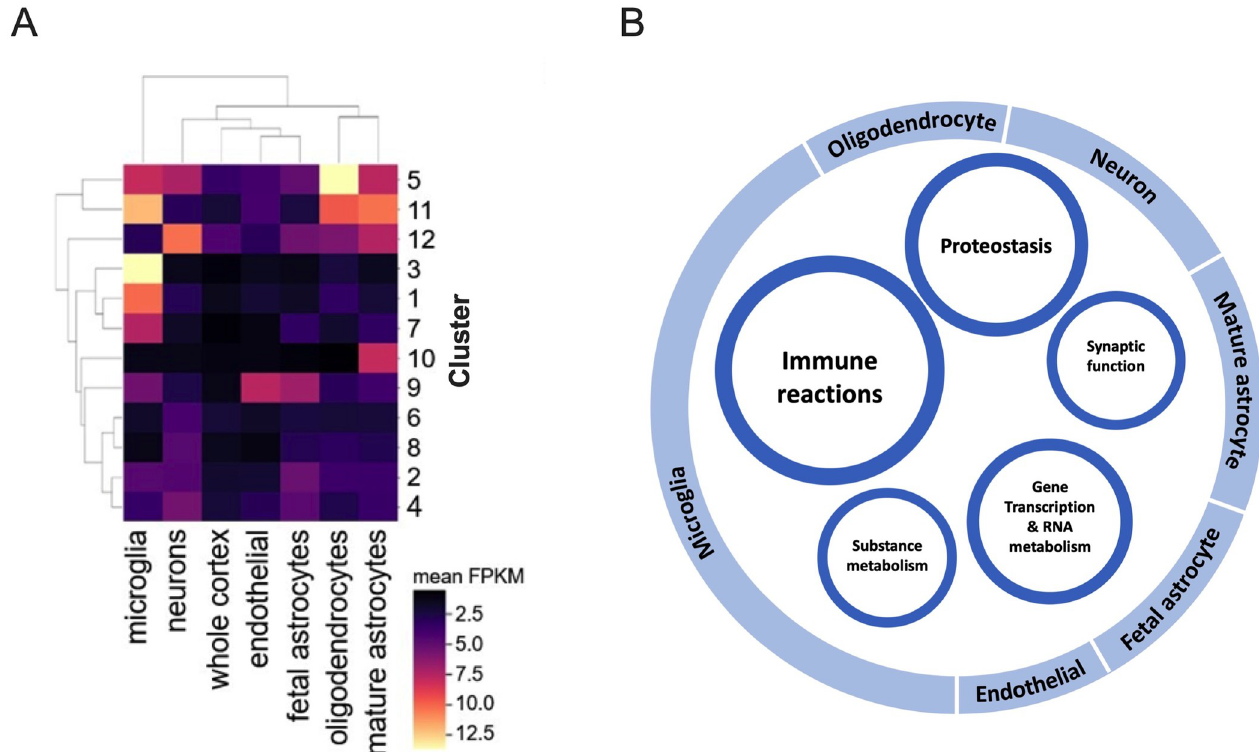
Fig 5. Cell-specific gene expression across clusters and schematic model. A) Mean expression (FPKM) from brain cell-types averaged across genes in each cluster (functional annotations for identified clusters are 1: Immunoregulatory interactions between a lymphoid and non-lymphoid cell, 2: RNA metabolic process, 3: Complement activation, 4: Protein modification by small protein conjugation, 5: Clathrin-mediated endocytosis, 6: SNARE binding, 7: Regulation of plasma lipoprotein particle levels, 8: EPH-Ephrin signaling, 9: DNA-binding transcription factor activity, 10: Acetylcholine-gated cation-selected channel activity, 11: Interleukin-1 signaling, 12: GABAergic synapse). B) Classes of identified pathways that are functionally related are presented as inner circles, with circle size roughly indicating relative class sizes. The overlying outer circle illustrates the types of cells in the central nervous system with overall preferential gene expression in each major class (e.g., microglia overlay the classes of Immune reactions and Substance metabolism because genes in multiple clusters of these two classes were highly expressed in